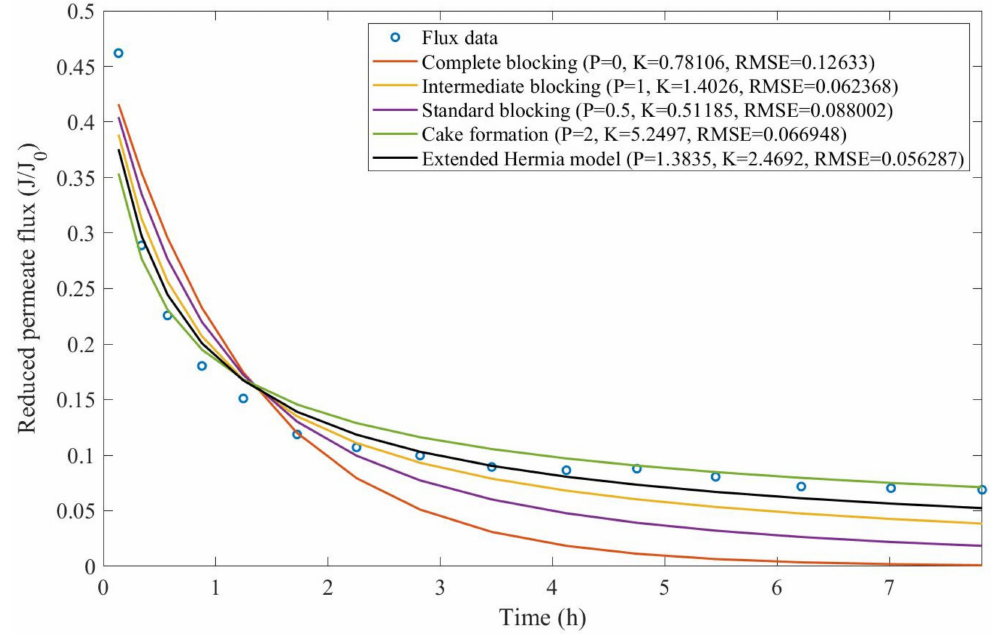
Figure A31. Model fitting for the second fouling stage of ultrafiltration of bovine serum albumin solution at 103.421 kPa considering the four original pore-blocking mechanisms and the extended Hermia model (Uncoated membrane)